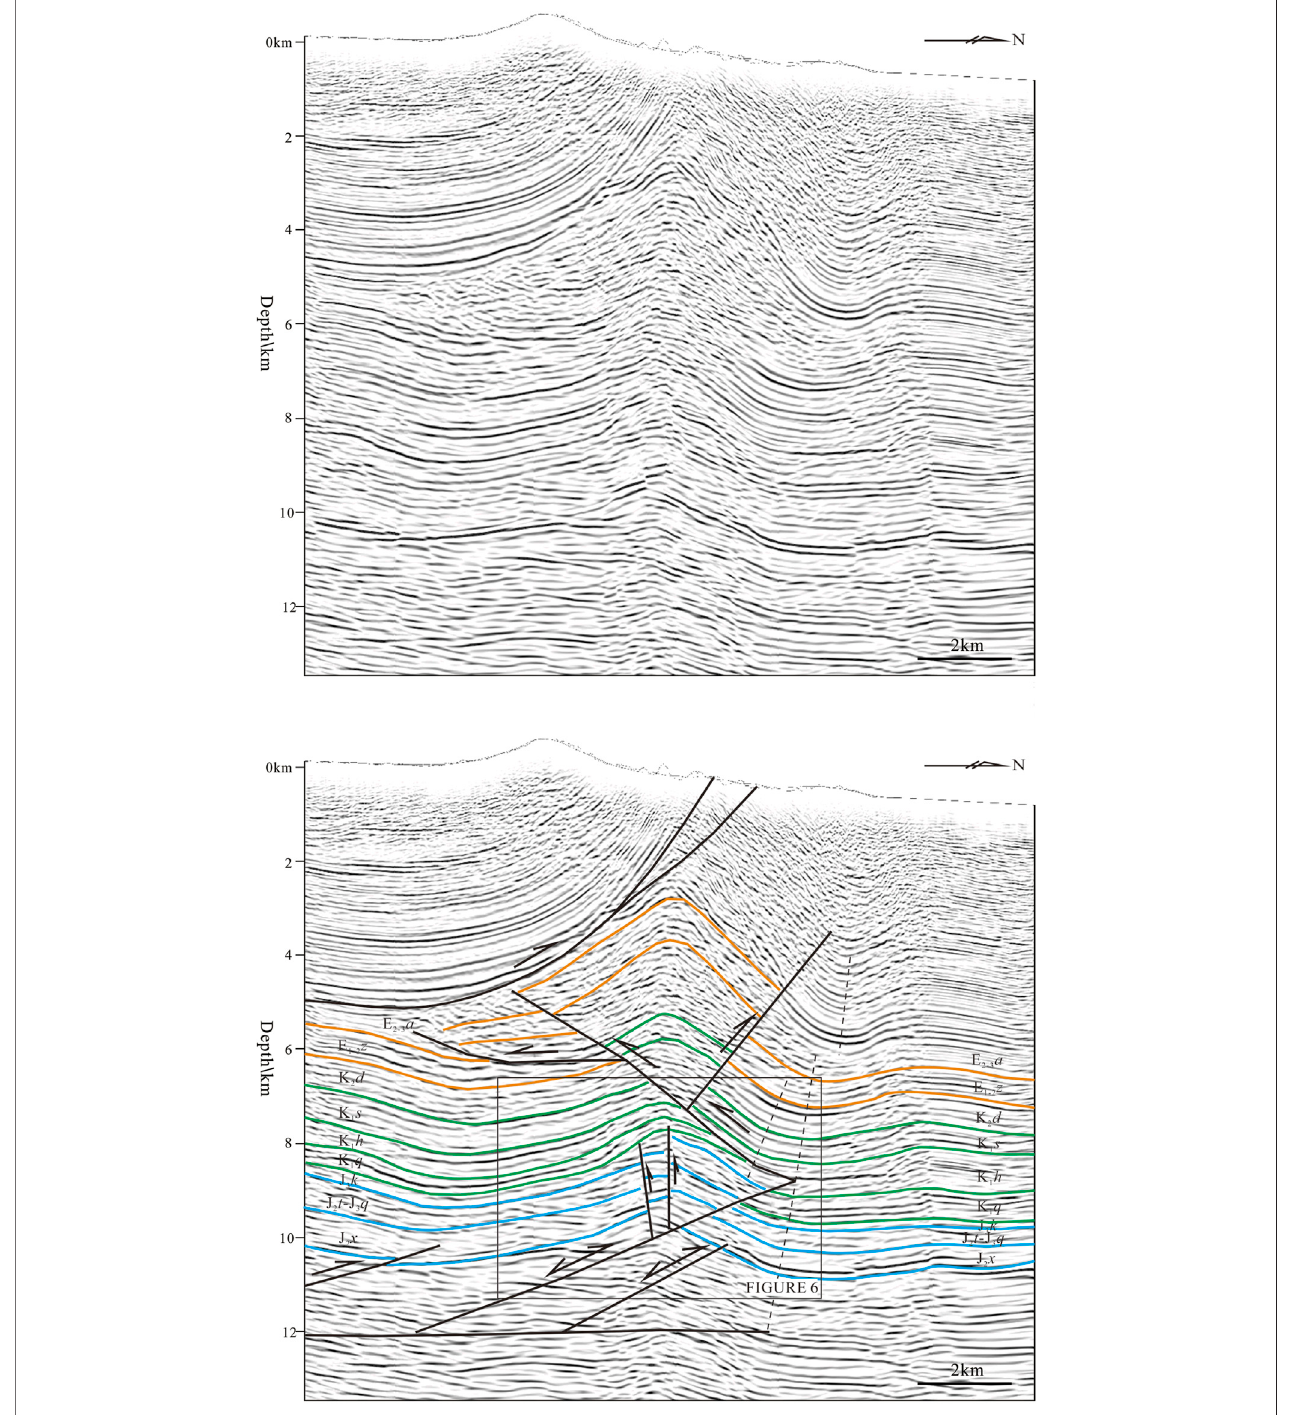
FIGURE 5 | Structural interpretation of seismic re fl ection across the Tugulu anticline showing the structural wedge in depth (for location see Figure 1C ).